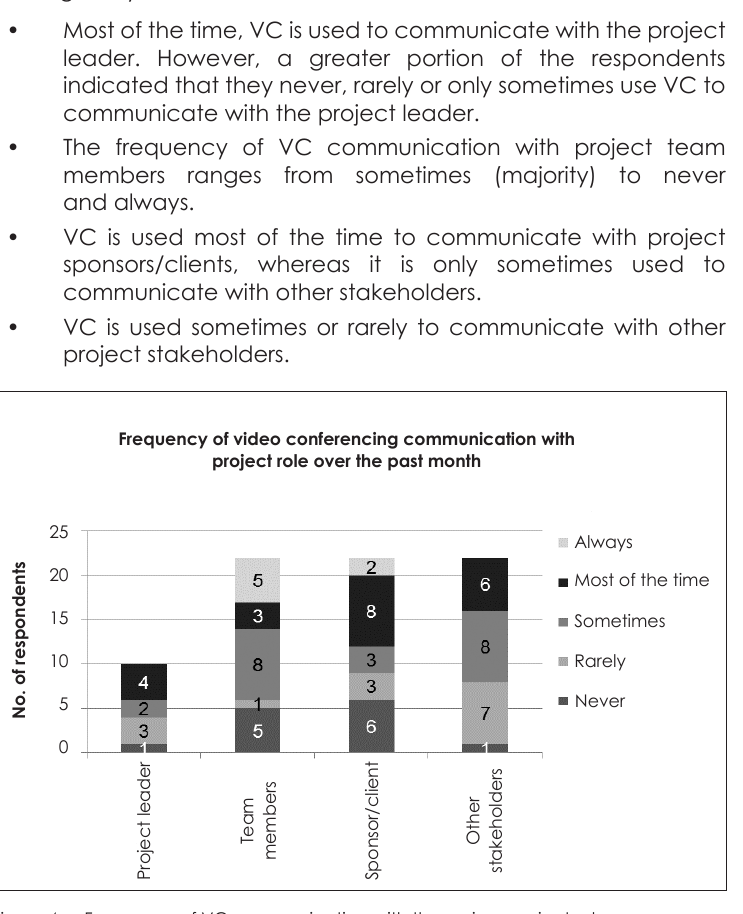
Figure 4: Frequency of VC communication with the various project roles The respondents were also asked if they use IM and VC to communicate one-to-one, or if they use these mediums to communicate with a group (relates to the audience factor). The results indicate that the majority of the respondents use IM to communicate one-to-one. The respondents were split over whether they would use the medium to communicate with a group of people. The results for VC indicate the opposite, in that the respondents use VC to communicate